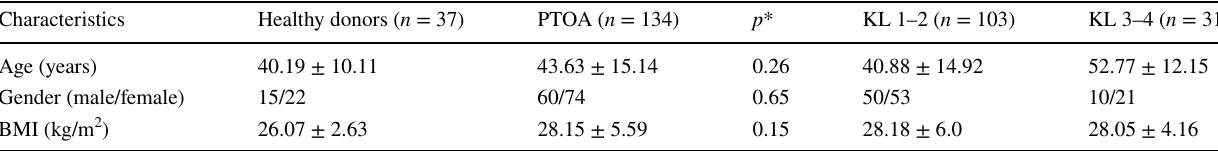
Table 2 Plasma and synovial fluid levels of soluble mediators in osteoarthritis patients and controls